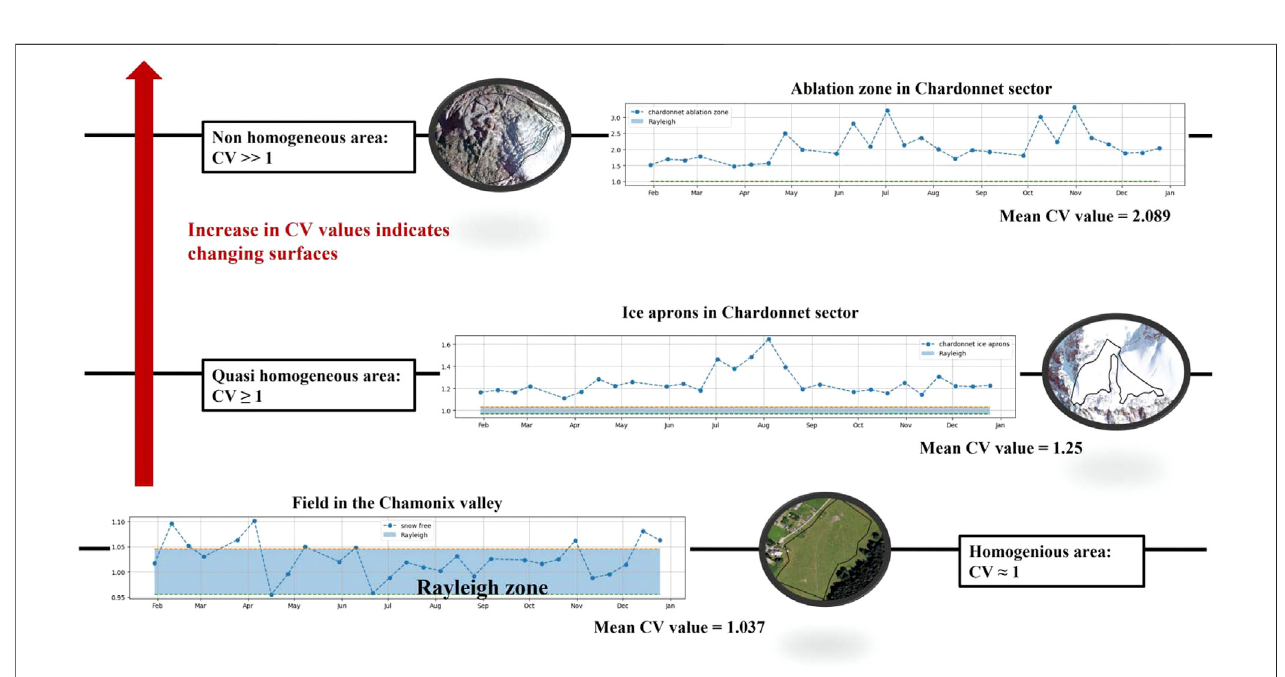
FIGURE 9 | Three cases in temporal pro fi les with an increased coef fi cient of variation. The fully developed speckle class ( fi eld area), a signal indicating some radiometric changes (IAs), and a signal with extreme variations of CV values indicate rapidly changing heterogenous surfaces (ablation zone of active glaciers).